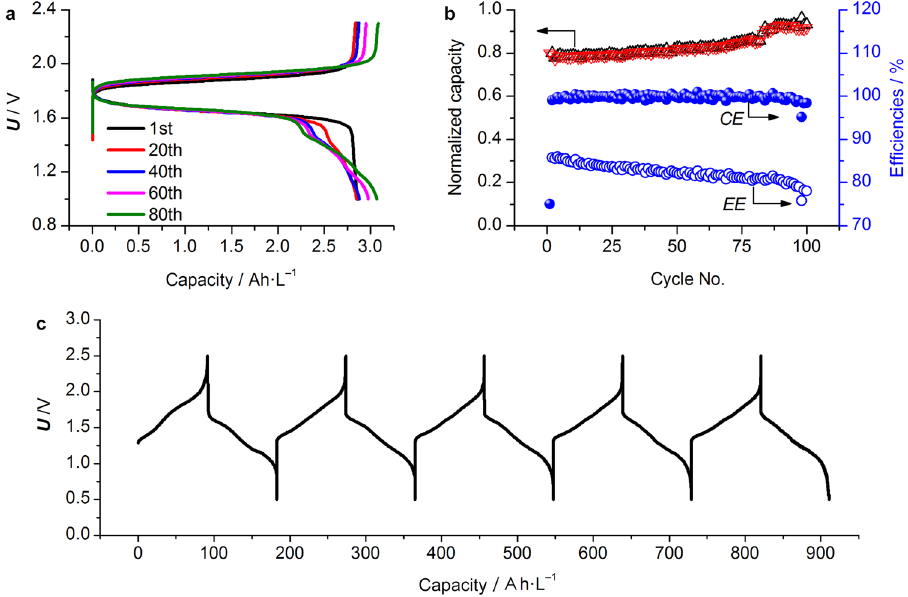
Figure 4. Electrochemical characterizations of Zn eutectic mixture | [Fe(phen) 3 ](BF 4 ) 2 and Zn eutectic mixture | LiI cells. ( a ) Charge/discharge profiles of Zn eutectic mixture | [Fe(phen) 3 ](BF 4 ) 2 cell assembled from 5 M Zinc eutectic mixture as anolyte and 0.2 M [Fe(phen) 3 ](BF 4 ) 2 and 0.8 M LiTFSI in EC/DMC as catholyte. The volume ratio of the anolyte and catholyte is 1:2; ( b ) corresponding charge/discharge capacity, Coulombic efficiency (CE) and energy efficiency (EE). The normalized capacity stands for the value of the actual capacity divided by the maximum capacity under such a cell configuration; ( c ) charge/discharge profiles of Zn eutectic mixture | LiI